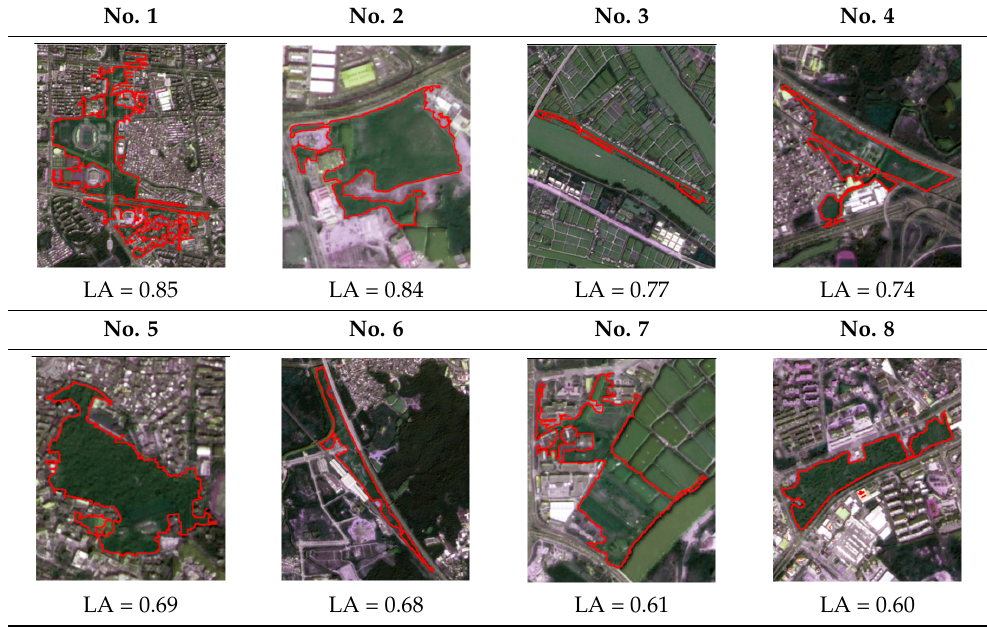
LA = 0.85 LA = 0.85